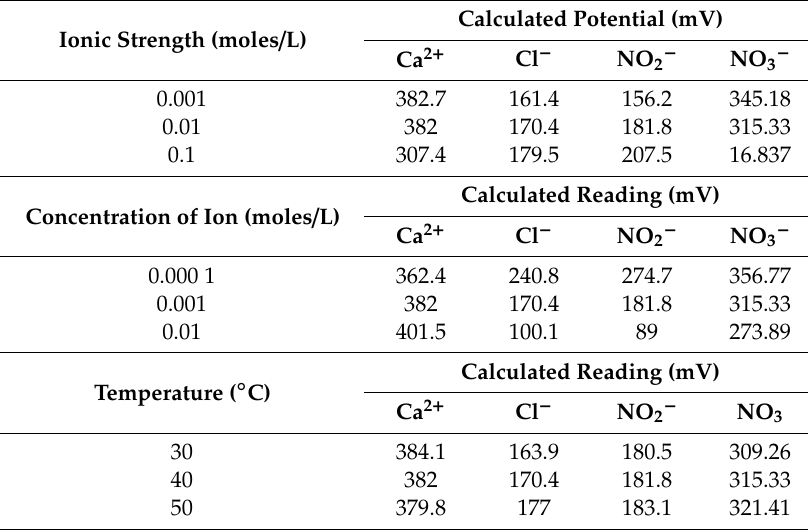
Table 7. Sensitivity analysis of Linear Regression